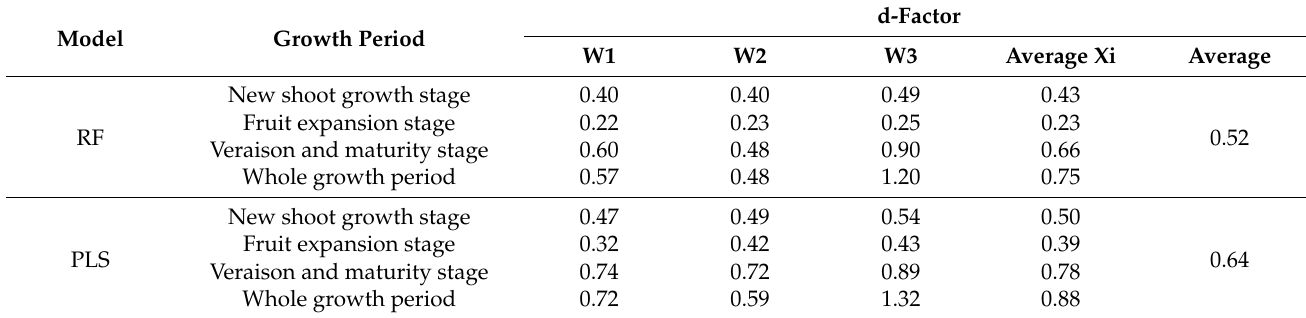
Table 4. Uncertainty measurement parameter (d-factor) for different